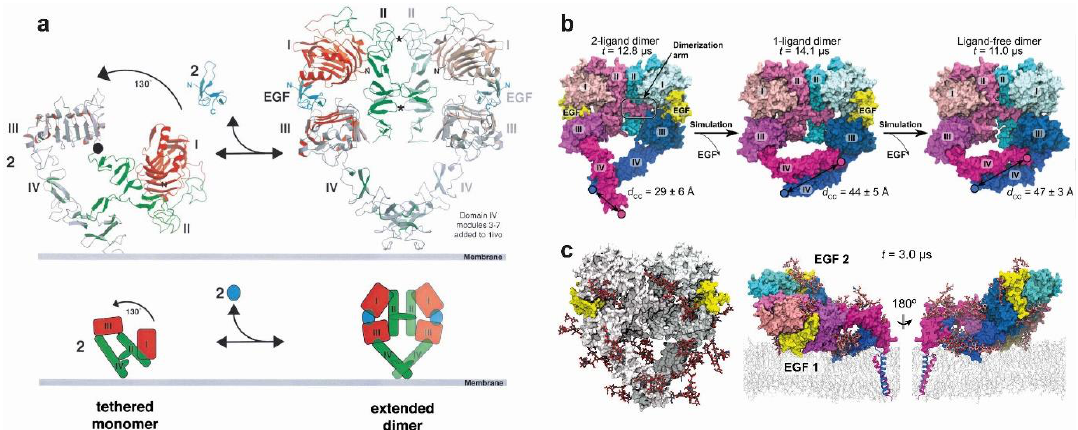
Figure 3. The ligand-bound extracellular back-to-back dimer. ( a ) A model of ligand-induced EGFR dimerization. The transition is shown between the monomer tethered structure on the left (model derived from [85]) and the active dimer on the right (model derived from [31]). The “back-to-back” dimer includes the DIV modules missing from earlier structures. Taken, with permission, from Burgess et al. [170]. ( b ) Simulation of the e ff ects of removal of the ligand, showing a significant rearrangement by which the gap between DI and DIII left by the detached ligand is filled, and a bending motion of DIV around the hinge region with DIII leads to a separation between the C-terminal portions of DIV. Taken, with permission, from Arkhipov et al. [67]. ( c ) A simulation showing the fully glycosylated ectodomain dimer. The glycans are coloured by atom type (carbon in grey, oxygen in red and nitrogen in blue). The conformation after 3 µ s of simulation is shown on the right, from two opposing viewpoints. Taken, with permission, from Arkhipov et al.